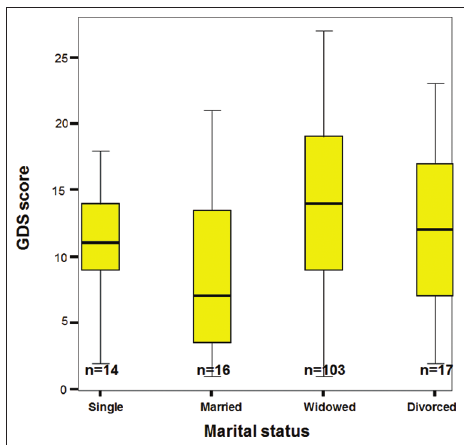
FIGURE 3. Relationship between GDS score and marital status. Married respondents were less severely